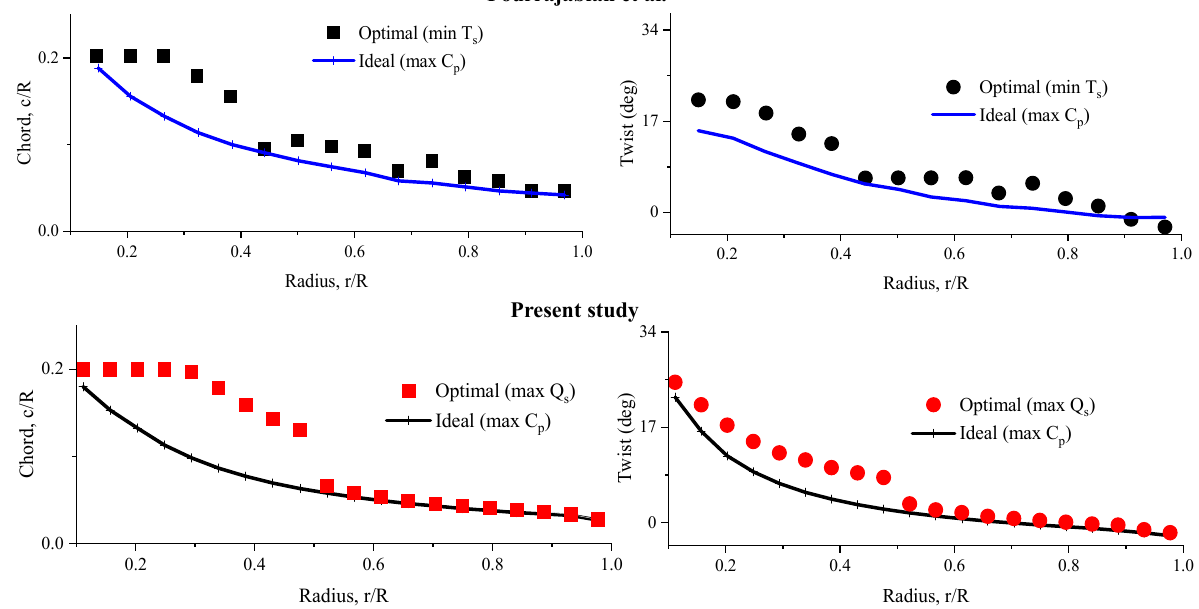
Figure 10. The θ and c profiles of the optimal blade in the research of Pourrajabian et al. [24] and the optimal blade of the present study.